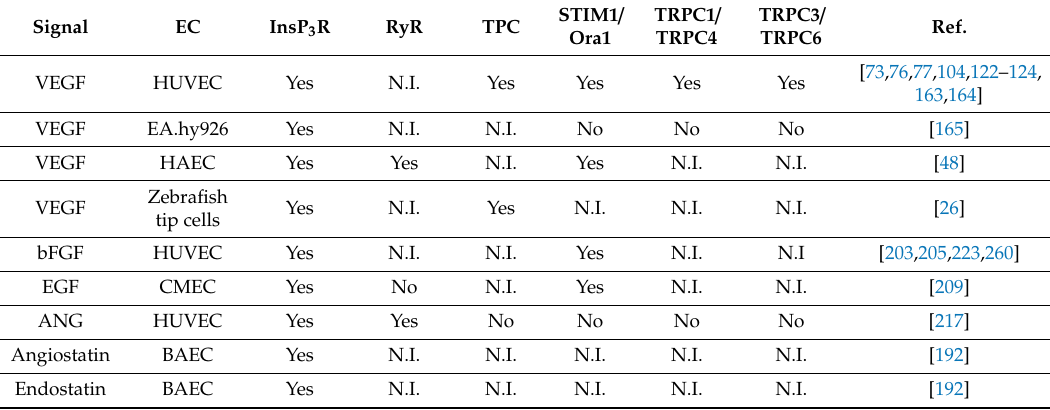
Table 1. The endothelial Ca 2 + toolkit: Recruitment by pro- and anti-angiogenic cues. Signal